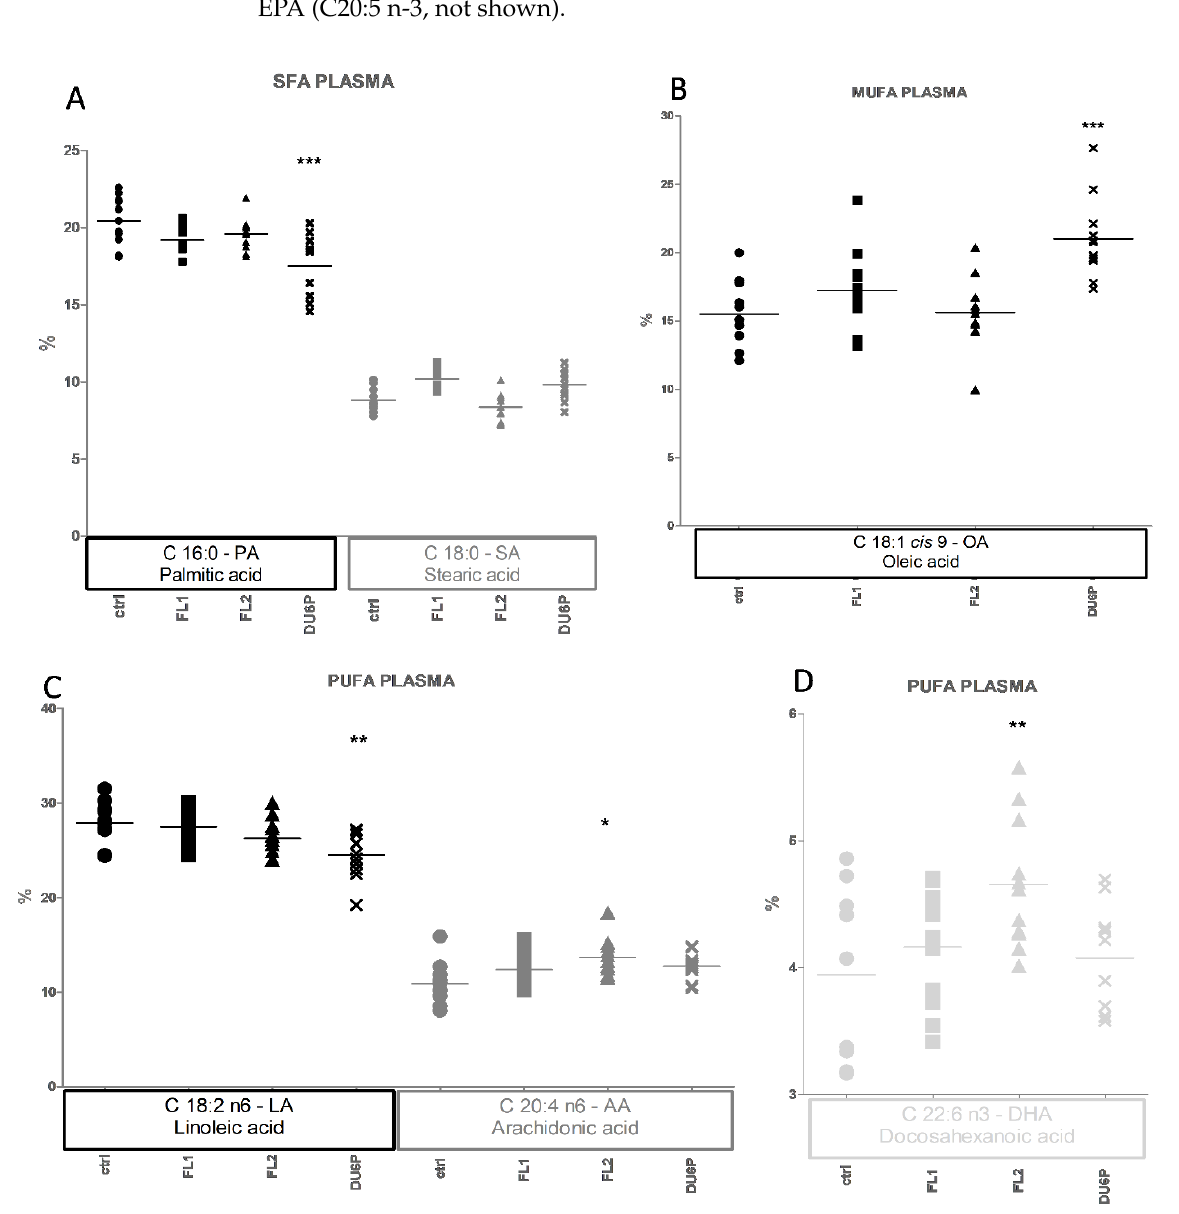
Figure 7. Plasma composition of the most abundant SFAs (small symbols, A ), MUFAs (medium symbols, B ), and PUFAs (large symbols, C , D ) in control (circles), FL1 (squares), FL2 (triangles) and DU6P (crosses). Different FAs are represented using different tonalities. Data are illustrated as the mean ± SEM (standard error of the mean) and designated significant if p < 0.05 (Bonferroni posttest: * p < 0.05; ** p < 0.01; *** p < 0.005, in comparison with control of the same group).